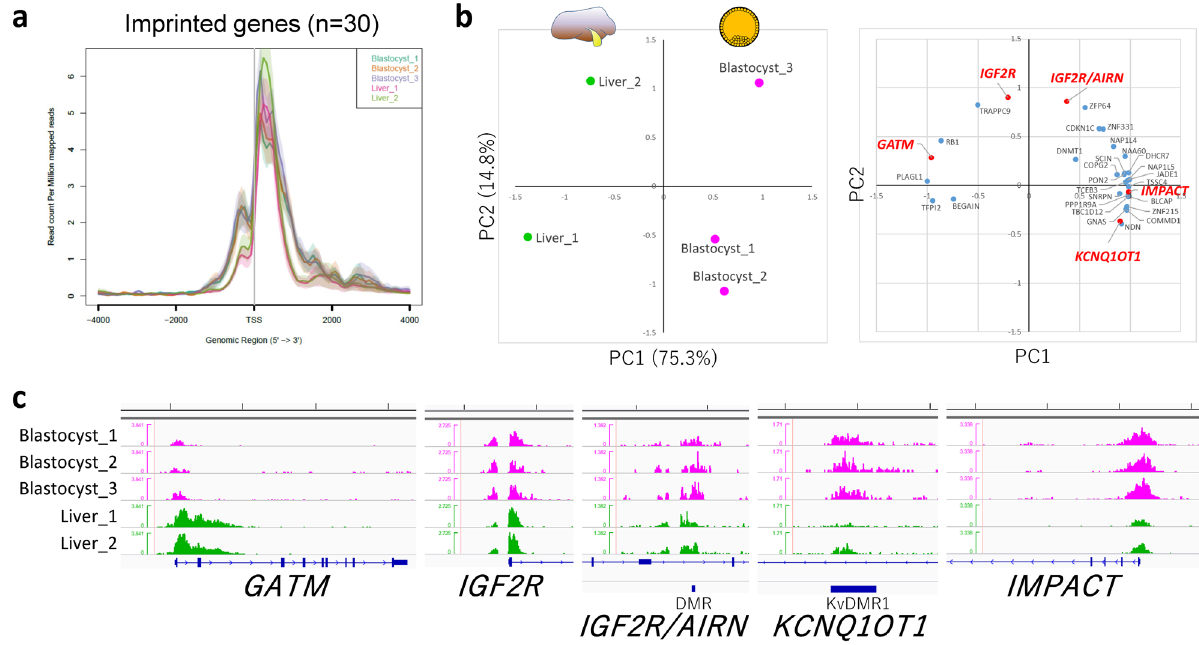
Figure 5. Characterization of H3K4me3 modifications common in blastocysts and liver in terms of imprinted genes. ( a ) Average profile plot of the H3K4me3 signal around the TSSs of 30 imprinted genes. ( b ) PCA of liver and blastocyst samples considering the peak areas around the 30 TSSs of the imprinted genes and two additional DMRs. Left and right panels show the principal component plot of all samples and loading plot of the loci examined, respectively. The genes whose H3K4me3 landscapes are shown in ( c ) are highlighted in red. ( c ) H3K4me3 landscapes of GATM , IGF2R , IGF2R/AIRN (DMR), KCNQ1OT1 (DMR), and IMPACT . Five-kb graduations are shown in the top scale.